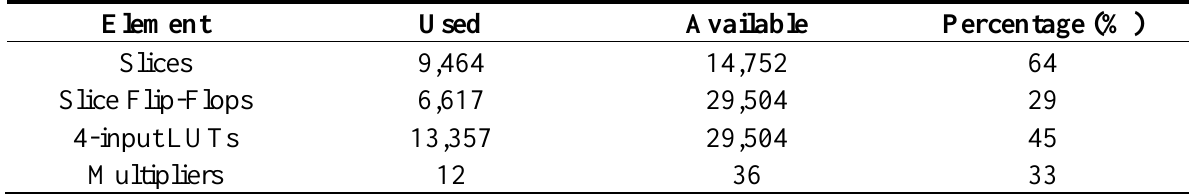
Table 3. FPGA resource